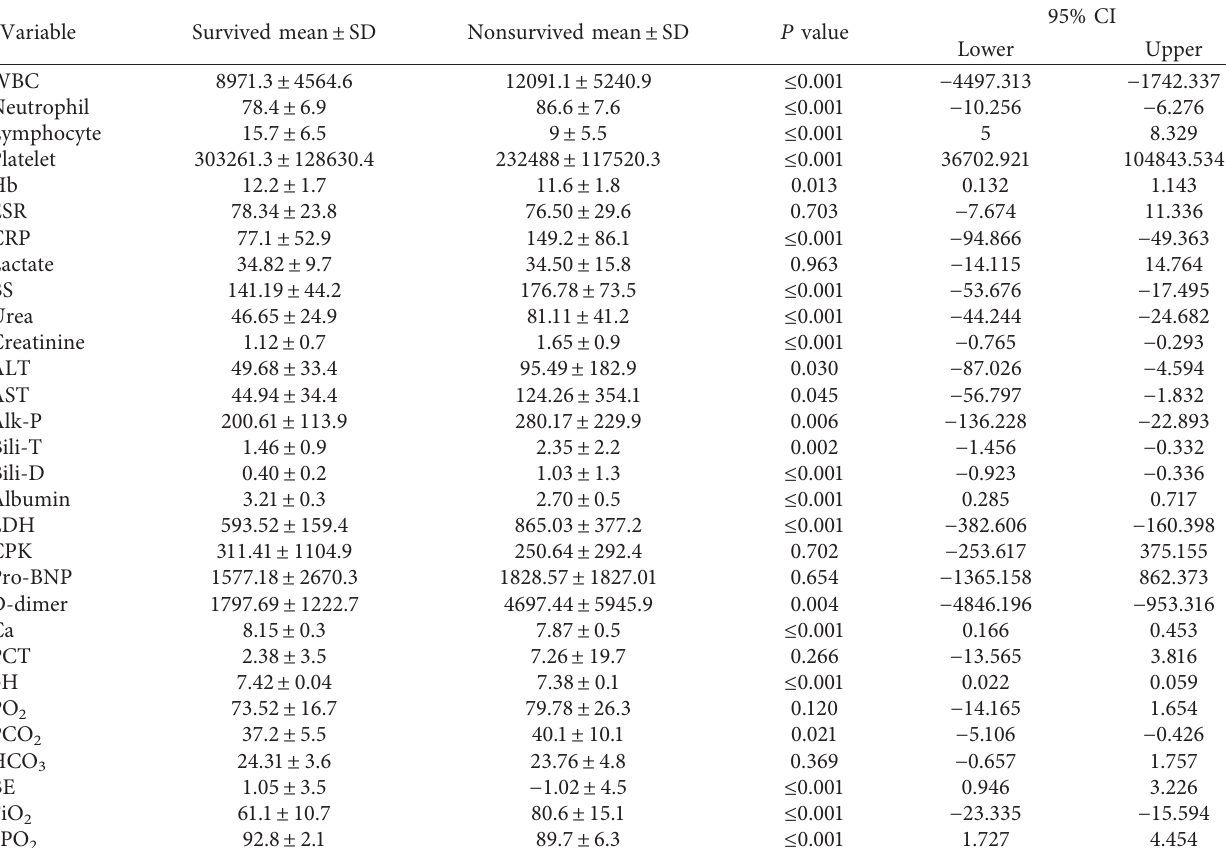
Table 4: Comparison of laboratory findings between survived and nonsurvived